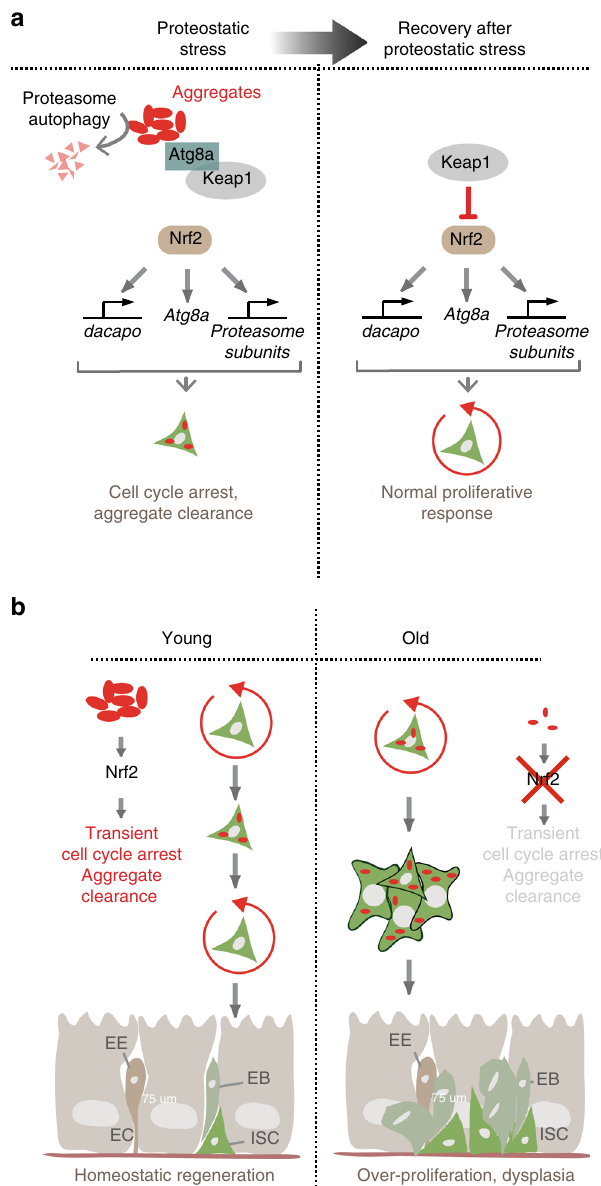
Fig. 7 A proteostatic checkpoint in intestinal stem cells. a Proposed model for activation of the proteostatic checkpoint in ISCs from young fl ies during proteostatic stress (i.e., presence of protein aggregates). The autophagy protein Atg8a is needed for Nrf2/CncC activation, and is proposed to act by sequestering Keap1. Activated Nrf2/CncC, leads to the upregulation of Atg8a, and dacapo, a cell cycle inhibitor, as well as genes encoding for proteins involved in aggregate clearance such as proteasome subunits. This Nrf2-mediated upregulation leads to a transient cell cycle arrest and aggregate elimination. Once aggregates are cleared, Nrf2 activity is reduced to basal levels and ISCs return to normal proliferative responses. b Proposed role of the proteostatic checkpoint in maintaining